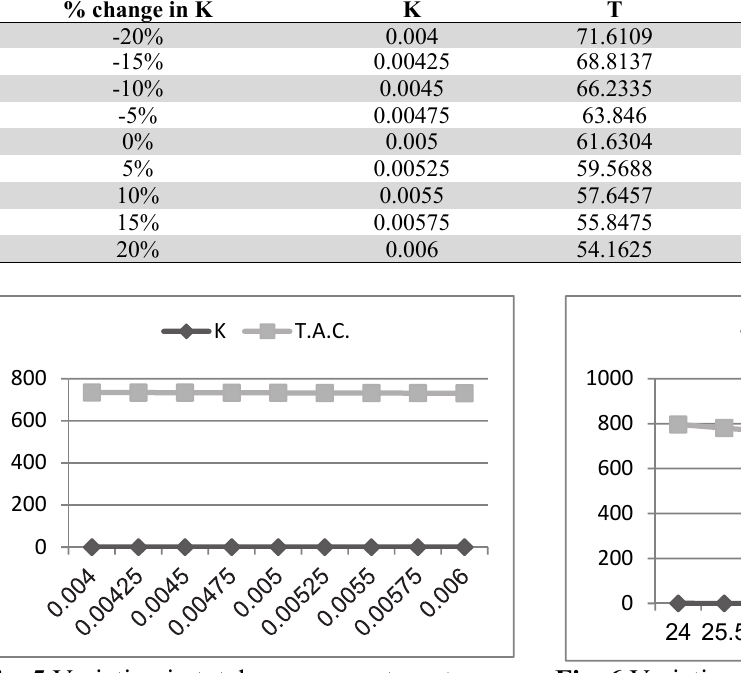
Fig. 5. Variation in total average cost w.r.t. Fig. 6. Variation in total average cost